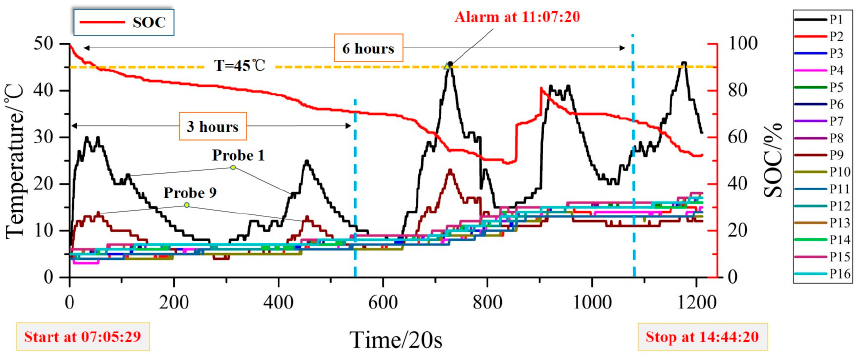
Figure 5. The temperature and SOC curves of Vehicle 1.